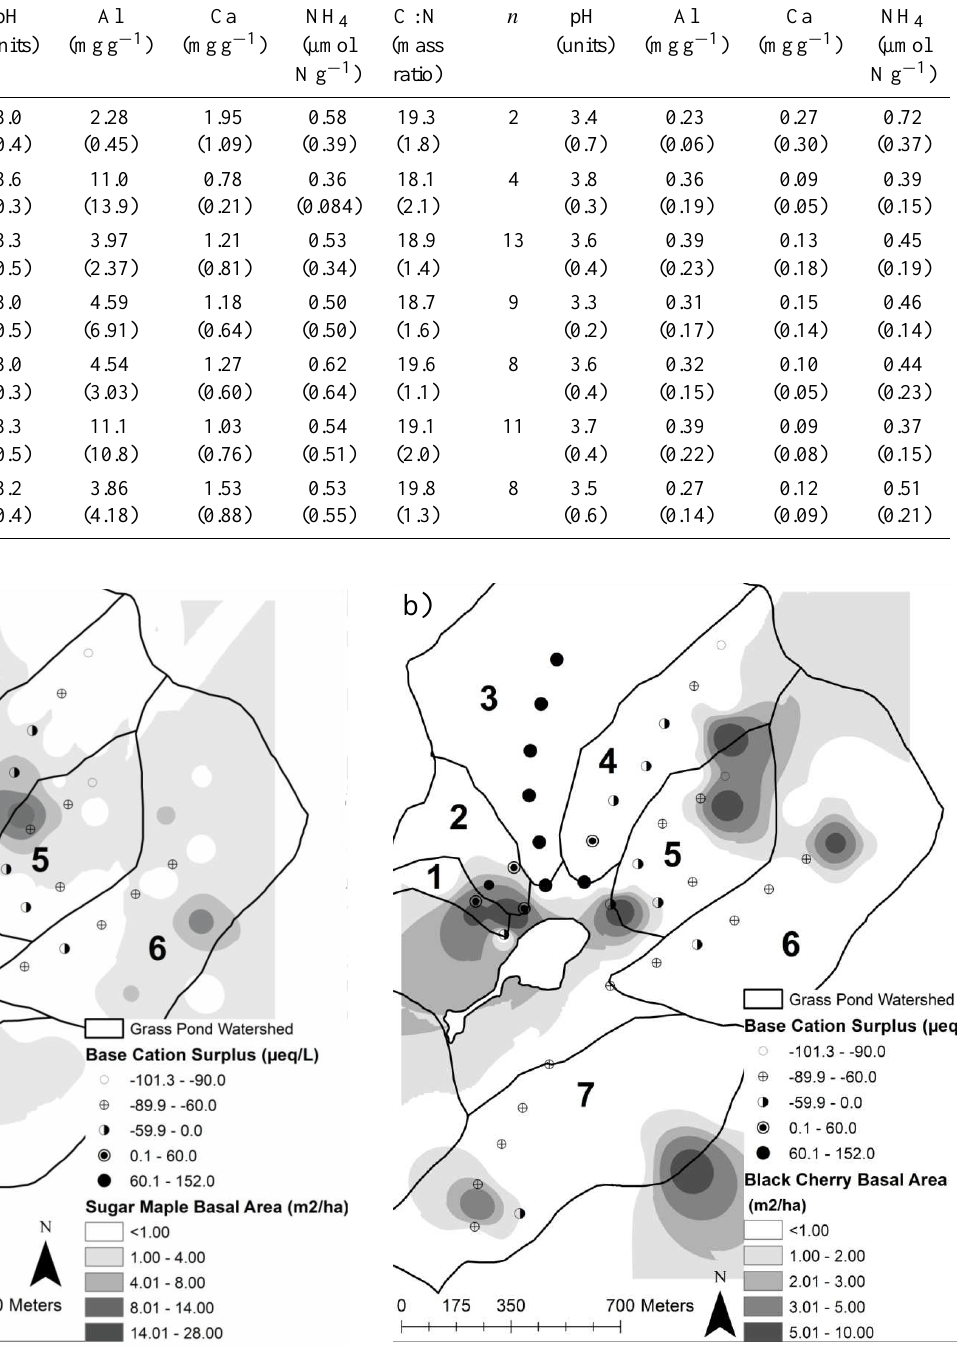
Fig. 4. (a) Stream BCS and sugar maple basal area upstream from the sample location. (b) Stream BCS and black cherry basal area upstream from the stream sample